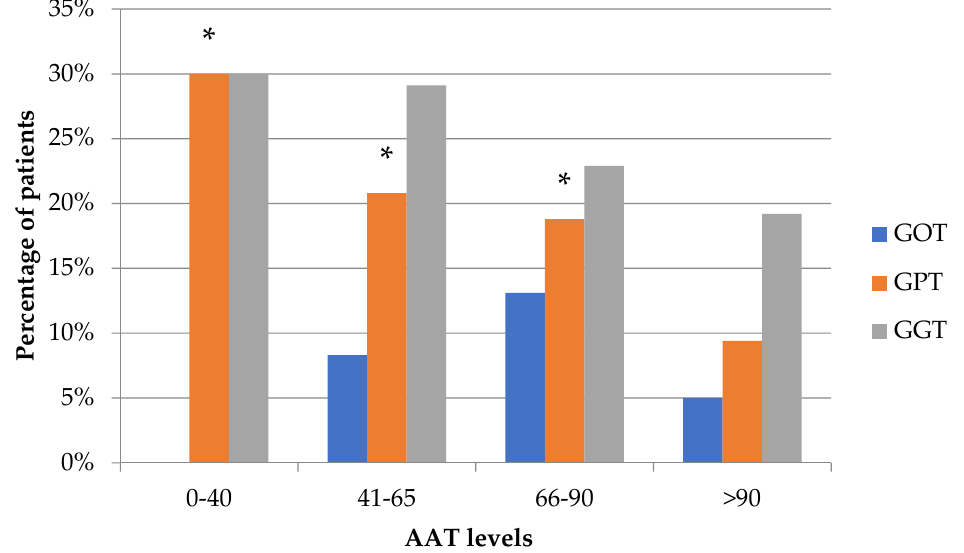
Figure 2. Relationship between transaminase levels (IU / L) and the di ff erent ranges of AAT levels (mg / dL). Transaminases (GOT > 37 U / L), (GPT > 38 U / L), and (GGT > 40 U / L). It can be seen that lower AAT levels were associated with statistically significant increases in transaminase levels ( p < 0.05) *. However, in the group with the lowest AAT values (0–40), no changes were observed in GOT. Correlation studies showed a statistically significant ( p < 0.001) negative correlation between AAT levels and GOT, GPT, and GGT